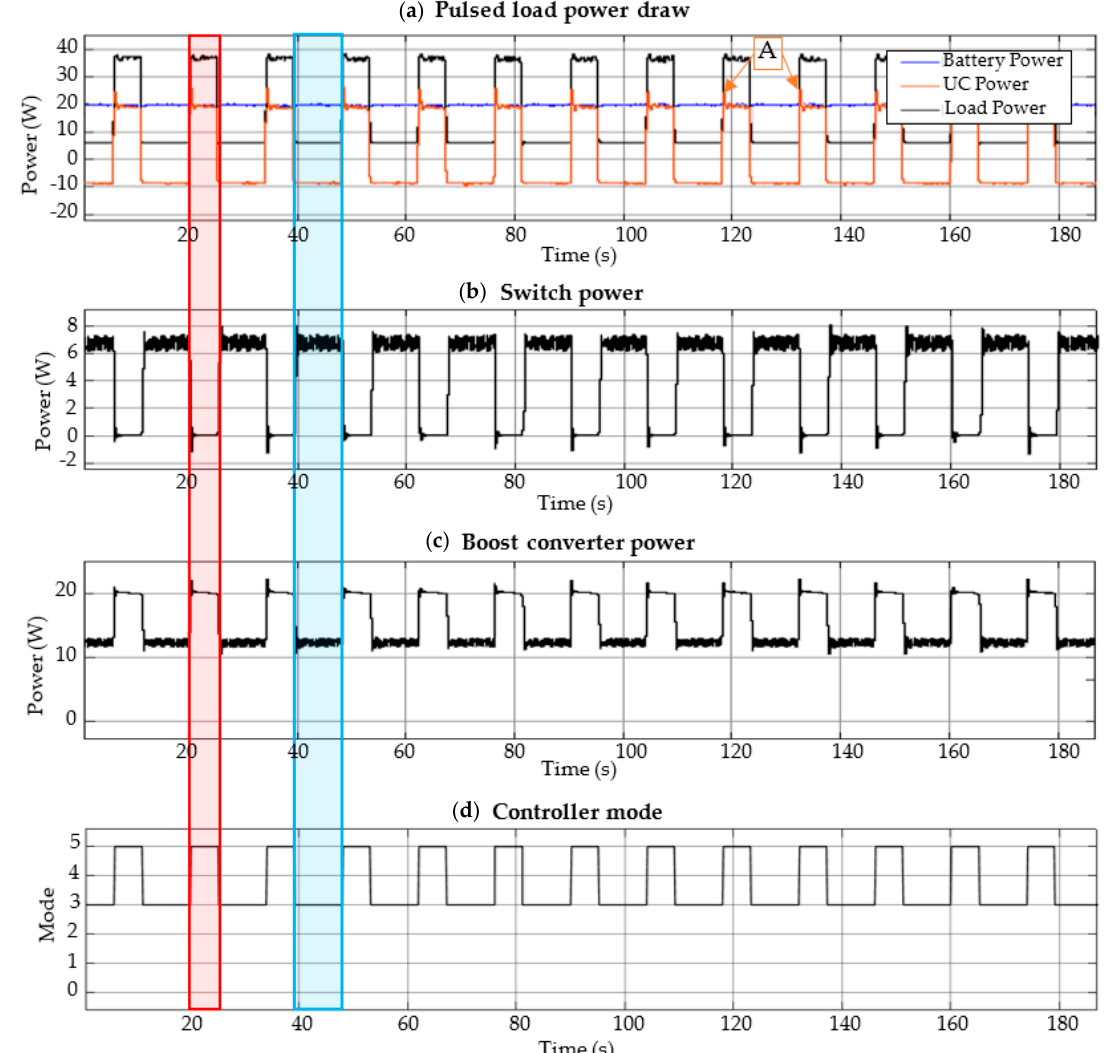
Figure 13. ( a ) Pulsed load power distribution; ( b ) Power through the switch; ( c ) Power transferred through the boost converter; ( d ) Controller operating mode.